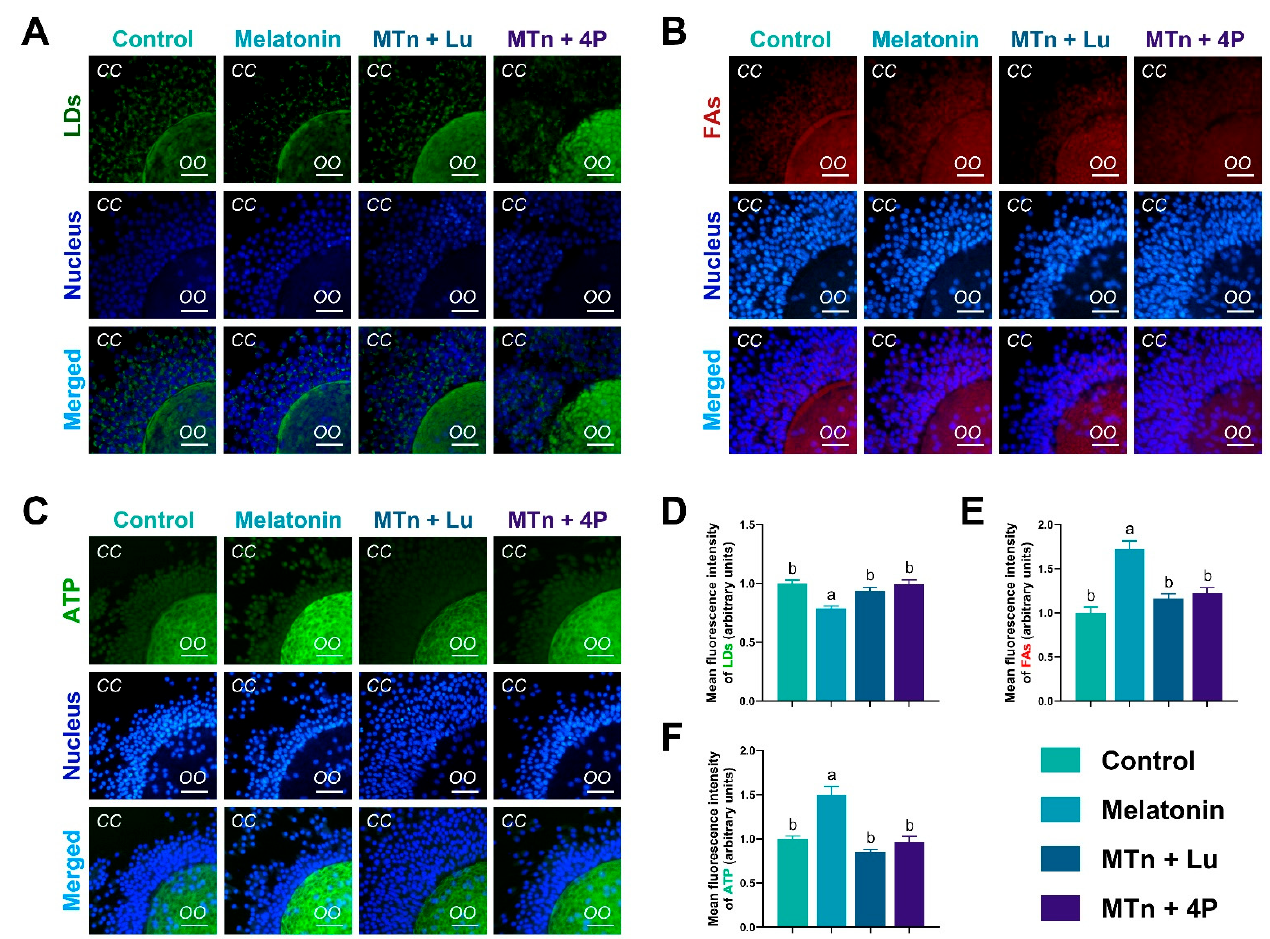
Figure 4. The contents of LDs, FAs and ATP in cumulus cells ( A – F ). Melatonin/MTn, 10 − 9 mol/L melatonin; Luzindole/Lu, 10 − 9 mol/L Luzindole; 4P-PDOT/4P, 10 − 9 mol/L 4P-PDOT. Scale bar = 30 µ m. Different letters denote significant difference ( p < 0.05).